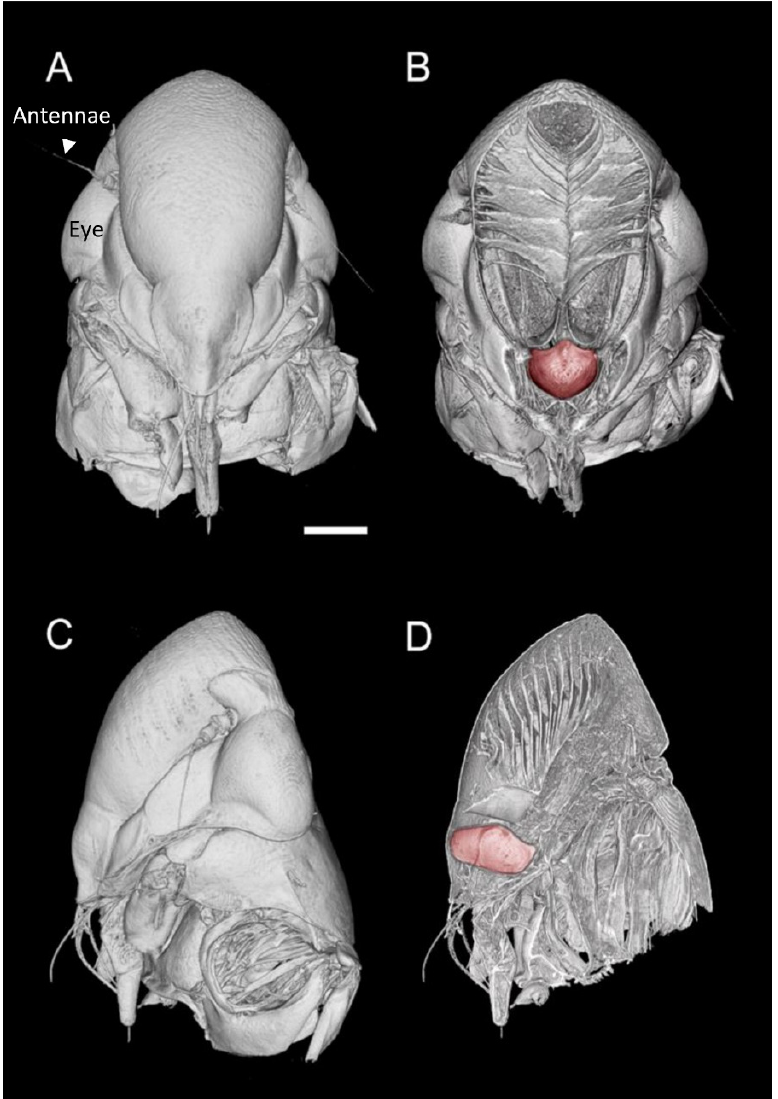
Figure 1. MicroCT three ‐ dimensional volume renderings of the GWSS head at low magnification presented in two orthogonal views ( A , C ) and paired with renderings where a virtual slice bisects the head to expose the mouthparts and foregut (false ‐ colored in red) ( B , D ). Bar = 250 μ m.